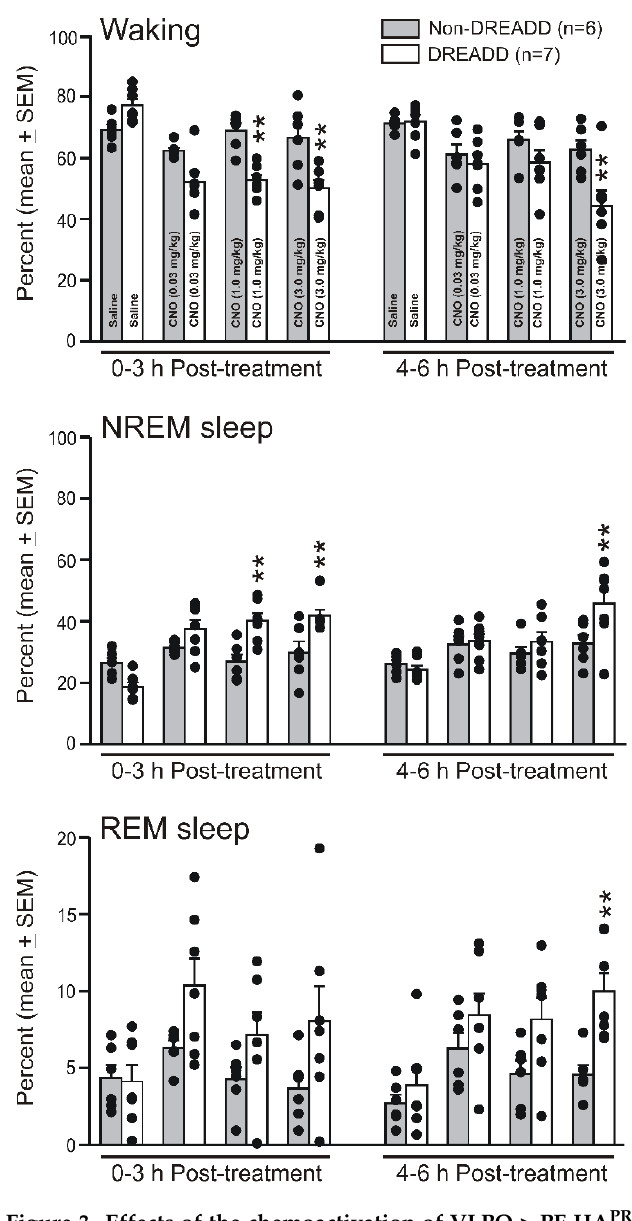
Figure 3. Effects of the chemoactivation of VLPO > PF-HA PRJ neurons on sleep–waking during the dark phase. The percent of time spent by the individual non-DREADD and DREADD rats (filled circles) and as respective groups (mean ± SEM; bars) in waking, nonREM sleep, and REM sleep during the six h (divided into first three and last three h) of recording after saline and three doses (0.3, 1.0, and 3.0 mg/kg) of CNO treatments. The treatments are indicated in the columns. The CNO-treated DREADD rats spent significantly less time in waking and more time in nonREM and, to some extent, REM sleep. The effects were time-dependent and more pronounced during the first three h after the CNO injection. Except for the 3.0 mg/kg of CNO, the sleep – wake profiles of the DREADD and non-DREADD groups after the various treatments during 3 – 6 h were comparable. ** p < 0.01 of significance compared to the non-DREADD control (one-way ANOVA followed by Holm – Sidak pairwise multiple comparisons).